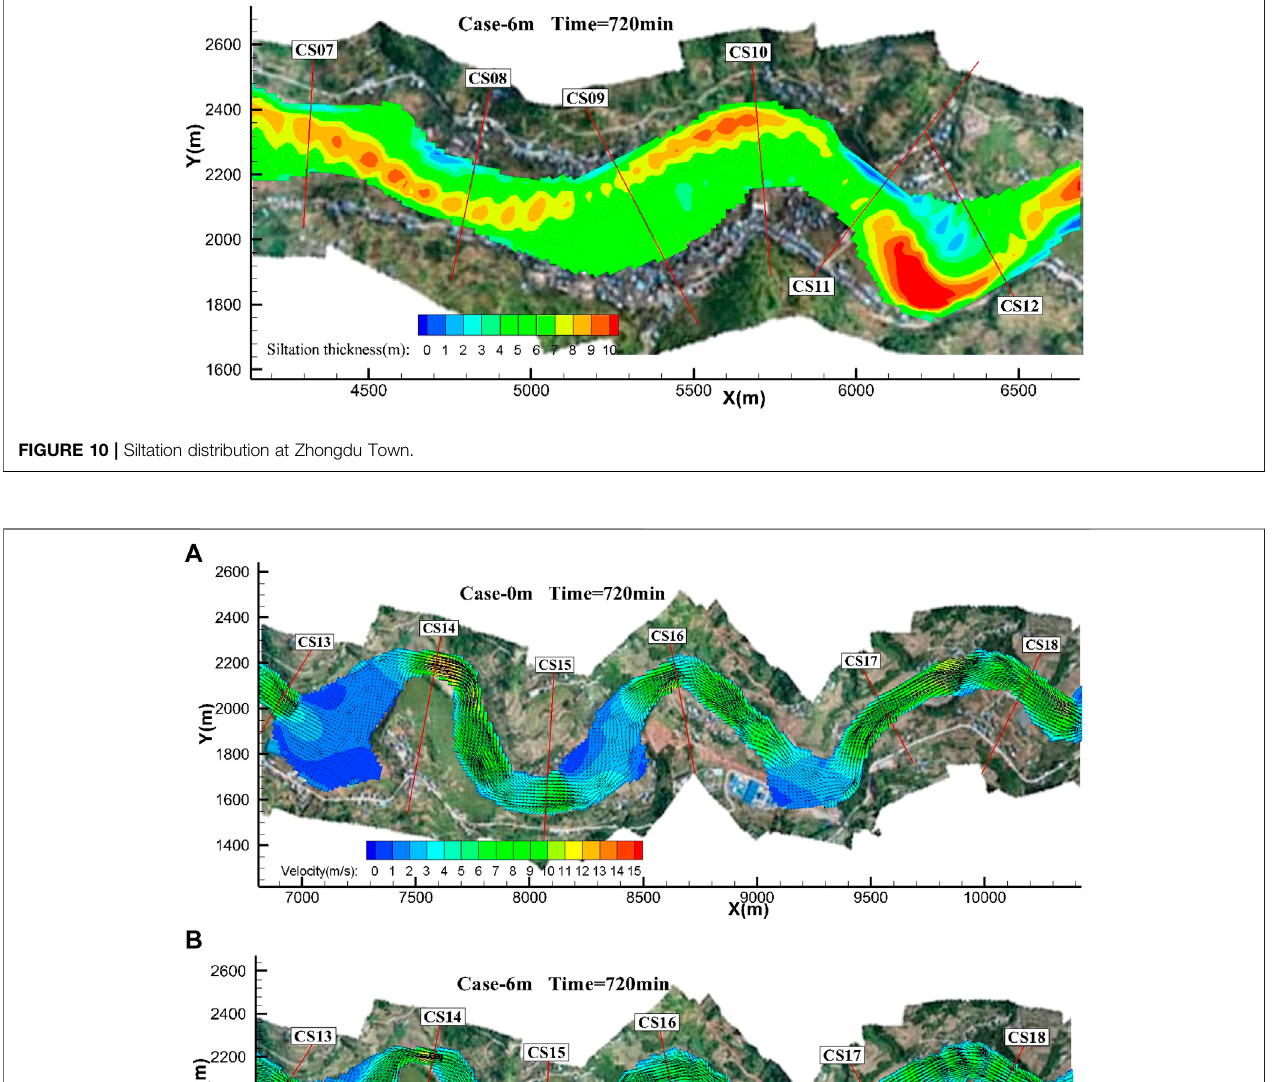
Frontiers in Earth Science |